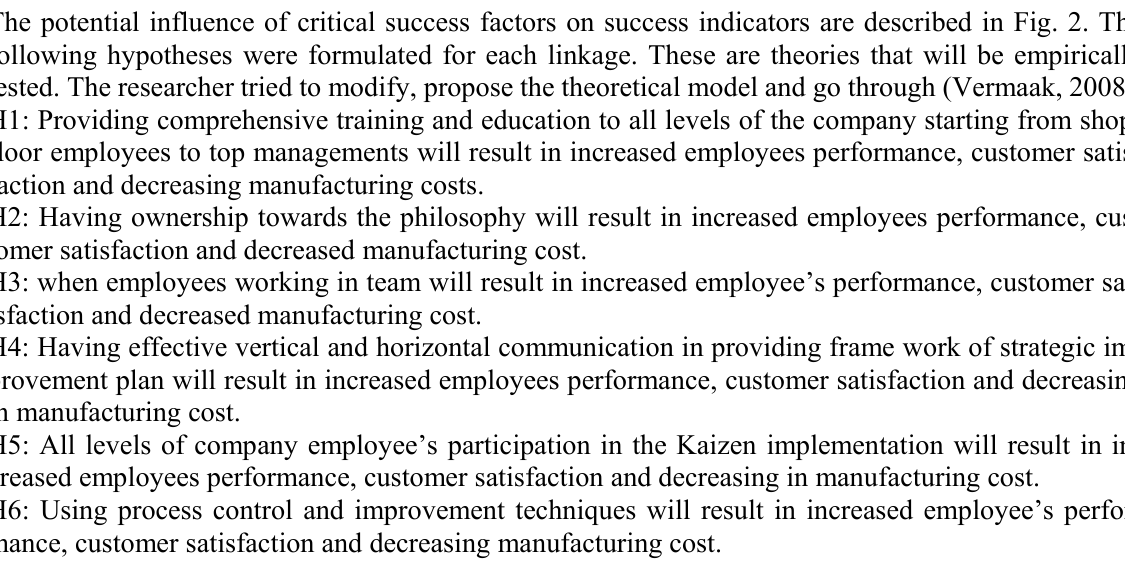
Fig.1. Flow chart of